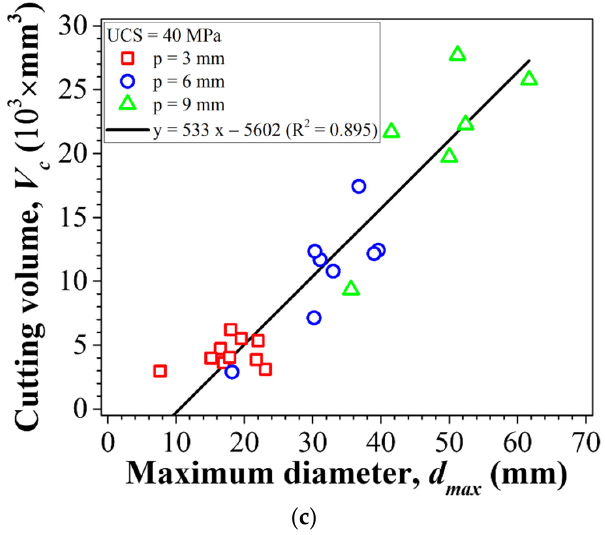
Figure 14. Relationship between maximum diameter and cutting volume: ( a ) rock of UCS 20 MPa; ( b ) rock of UCS 30 MPa; ( c ) rock of UCS 40 MPa.